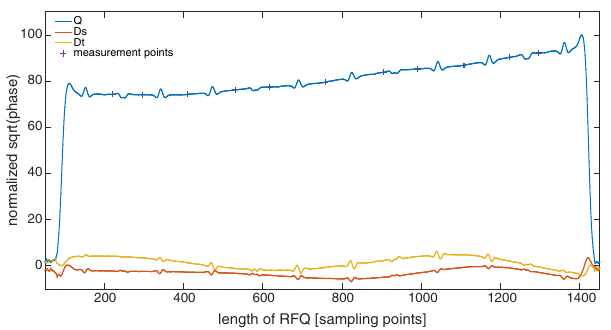
FIG. 11. The plot shows the relative longitudinal field distri- bution of the Q, Ds and Dt components before tuning. The longitudinal measurement locations are marked as crosses.